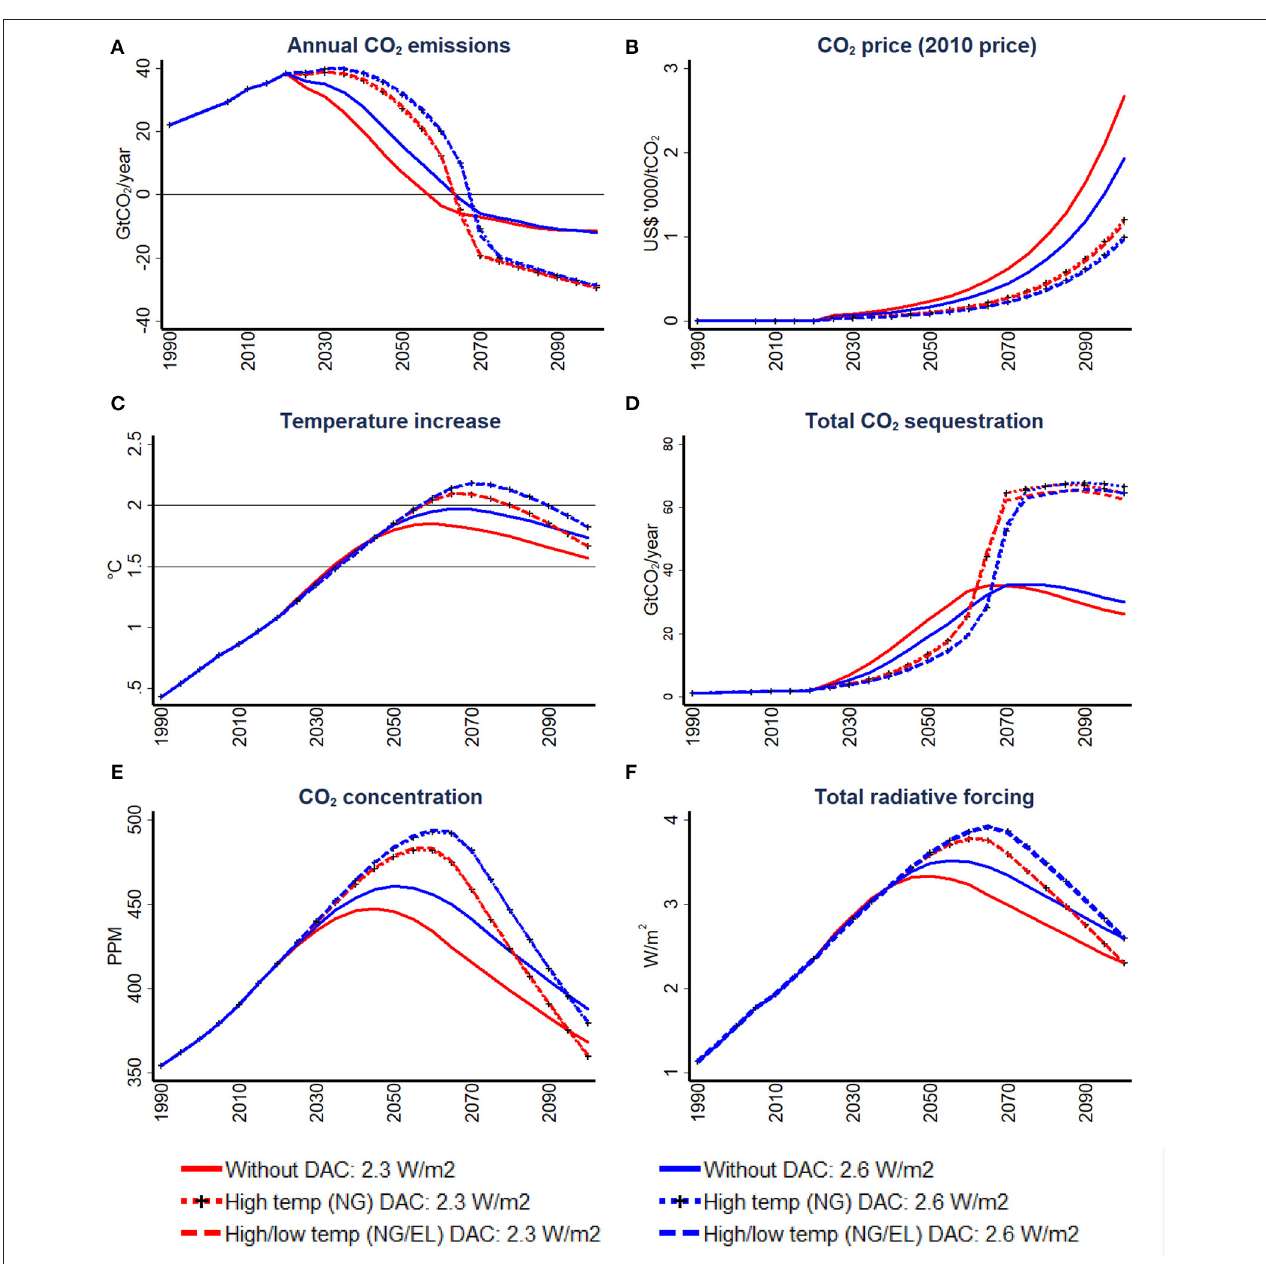
FIGURE 2 | Effects on the global CO 2 emissions path (A) , CO 2 prices (B) , global mean temperature (C) , the total CO 2 sequestration (D) , CO 2 concentration (E) , and the total radiative forcing (F) under the least cost strategy scenarios that aim to achieve climate mitigation goal by limiting the total radiative forcing to 2.3 W/m 2 by year 2100 (shown in red color) and 2.6 W/m 2 by year 2100 (shown in blue color), respectively. The scenario “Without DAC” includes only BECCS and AR, the scenario “High temp (NG) DAC” includes a high temperature natural gas-based DAC in addition to BECCS and AR, and the scenario “High/low temp (NG/EL) DAC” includes three types of DAC (high temperature natural gas-based DAC, high temperature electricity-based DAC and low temperature electricity-based DAC) in addition to BECCS and AR. “High/low temp (NG/EL) DAC” scenario, expanding the portfolio of DAC, by including two additional high and low temperature electricity-based DAC, does not significantly differ much from High/low temp (NG) DAC since the major share of the DAC deployment is high temperature natural gas-based.